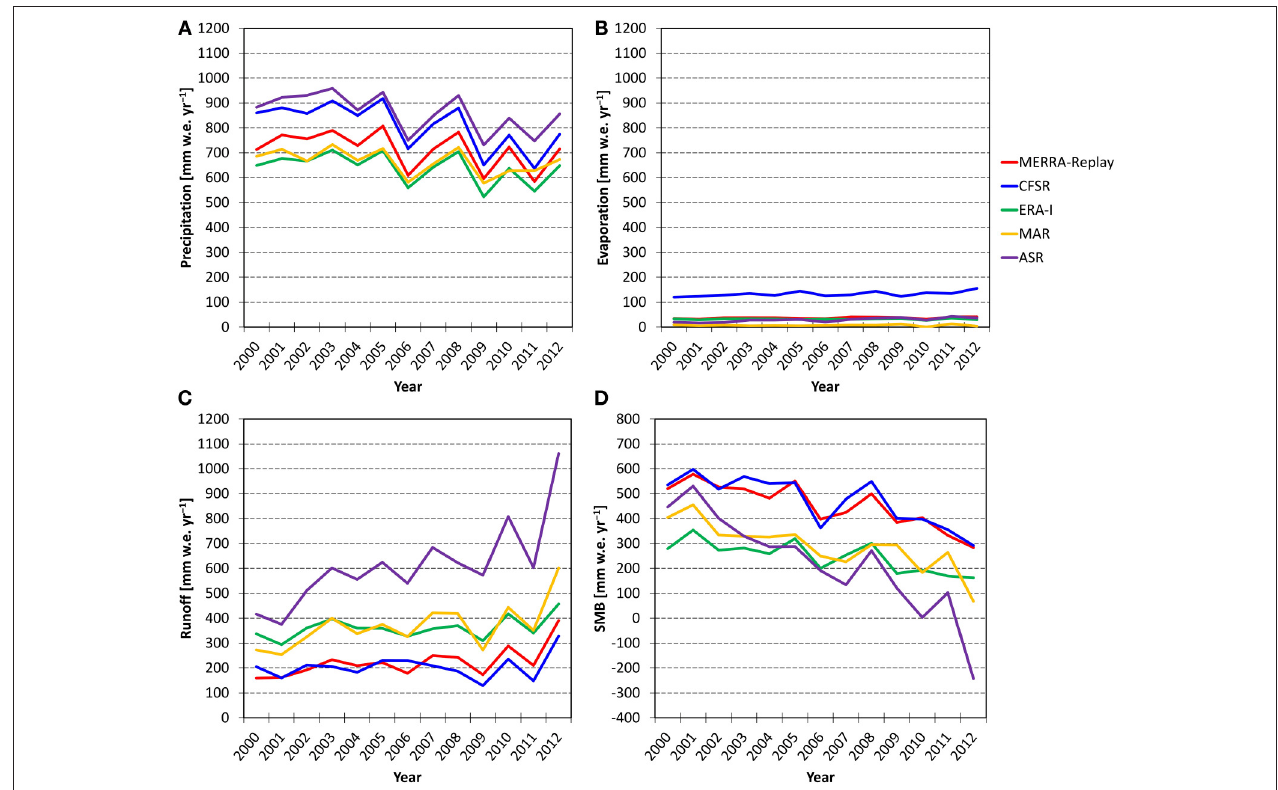
FIGURE 2 | Time series of annual (A) precipitation, (B) evaporation, (C) runoff, and (D) SMB averaged over the GrIS from five data sources, in mm water equivalent (w.e.) yr − 1